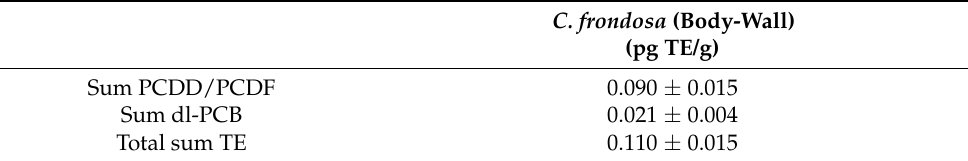
Table 5. Sum concentrations (pg toxic equivalents (TE)/g wet weight) of dioxins and furans (PCDD/PCDF), dioxin-like PCB (dl-PCB), and the total sum TE, for orange-footed sea cucumber ( Cucumaria frondosa ) (average ± SD, n = 4). All values below or equal to the level of detection (LOD) were set equal to LOD.